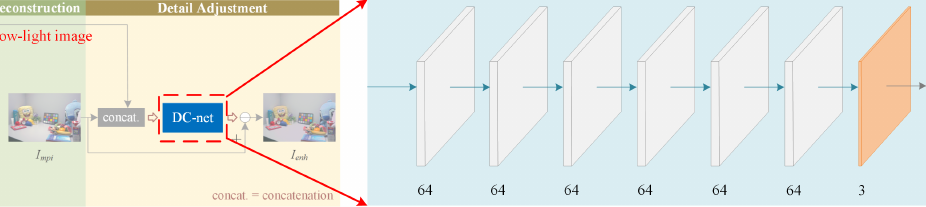
Figure 4. The architecture of the DC-net. The input is the concatenation of the L mpi and the low-light image, and the output is a residual map with detailed